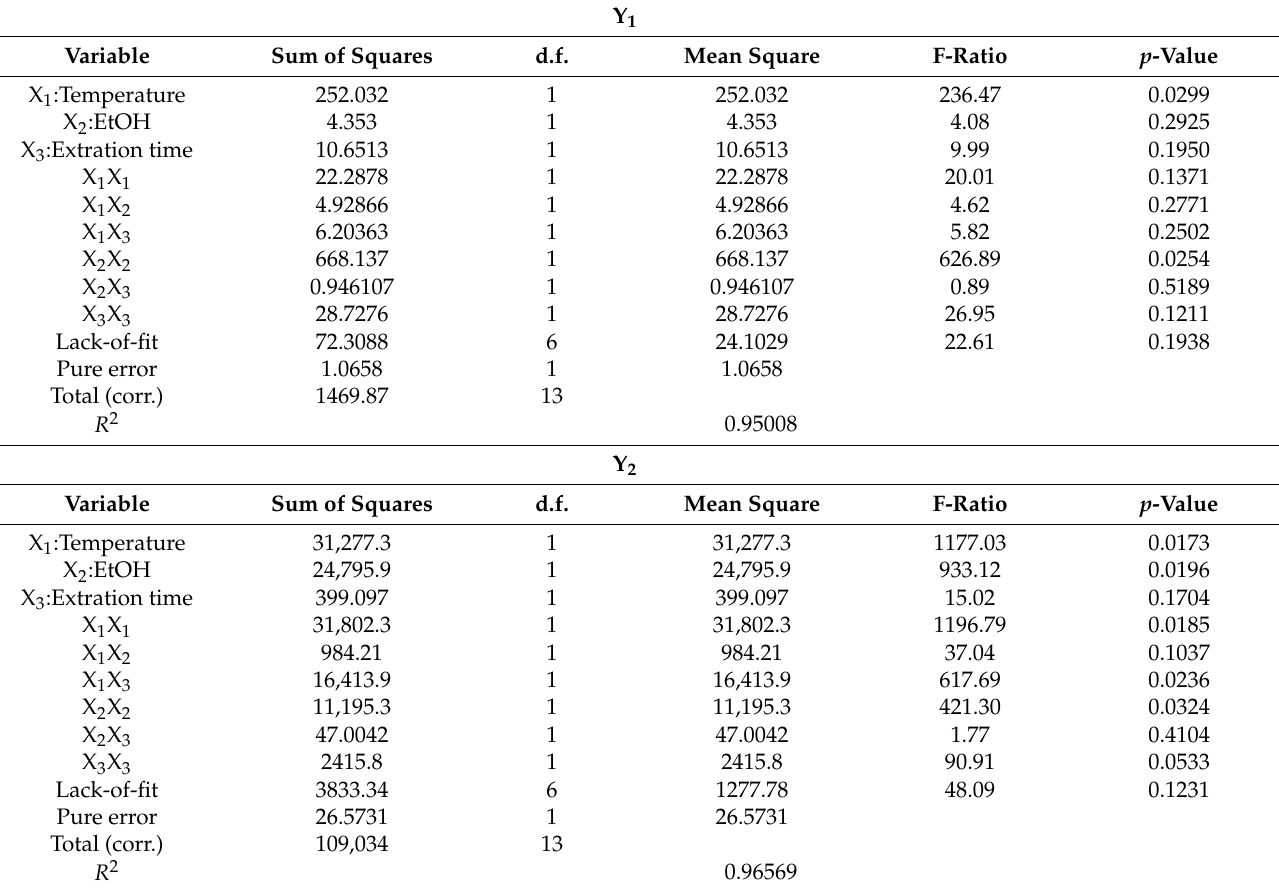
Table 7. Variance analysis of the proposed experimental model. Y